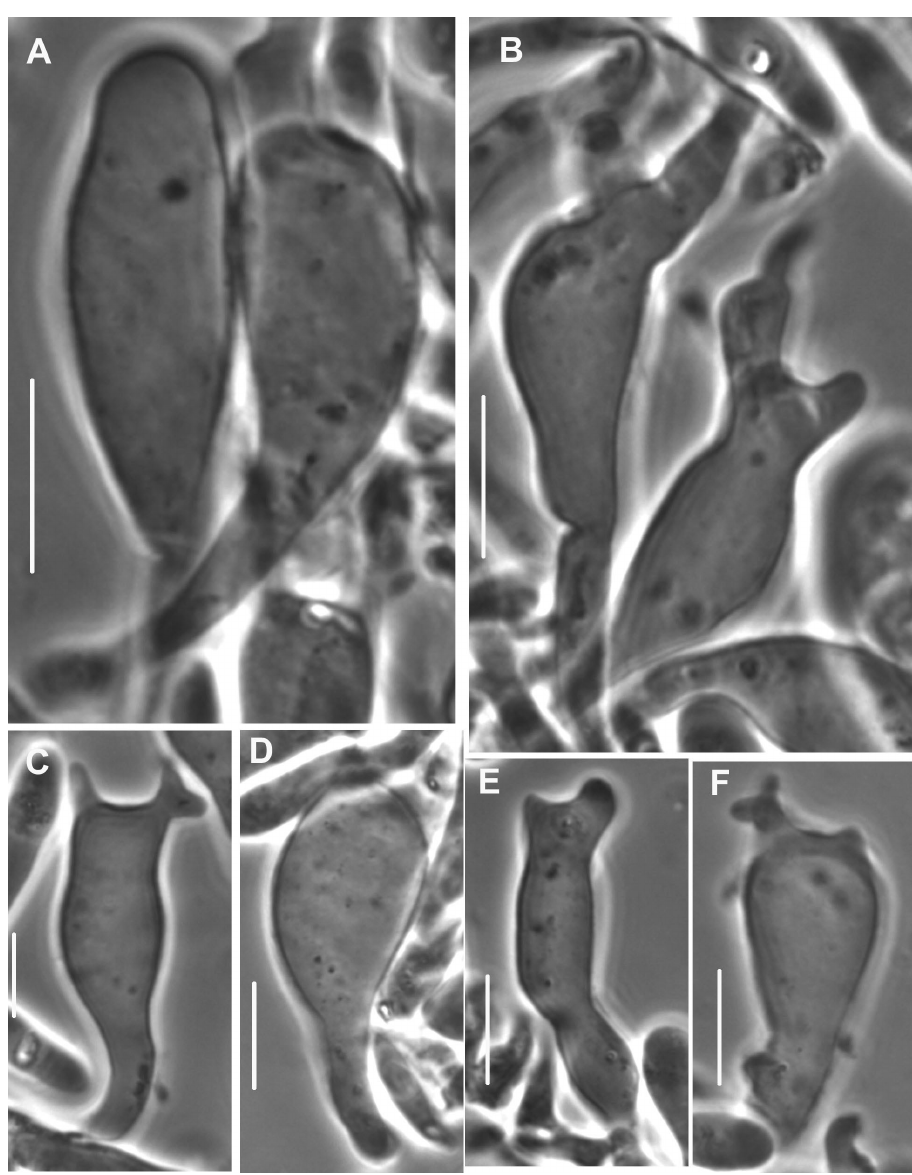
Figure 26. Mycetinis copelandii . Cheilocystidia. Standard bars = 10 µm. TFB 8084 (TENN-F-55408). Commentary. The free-form cells of the pileipellis are reminiscent of those of members of Gymnopus ( Micromphale ) sect. Perforantia and ( Marasmius ) sect. Androsacei but are considerably more complex. The size of the lobes are like the broader lobes of some pileipellis lobes in the same